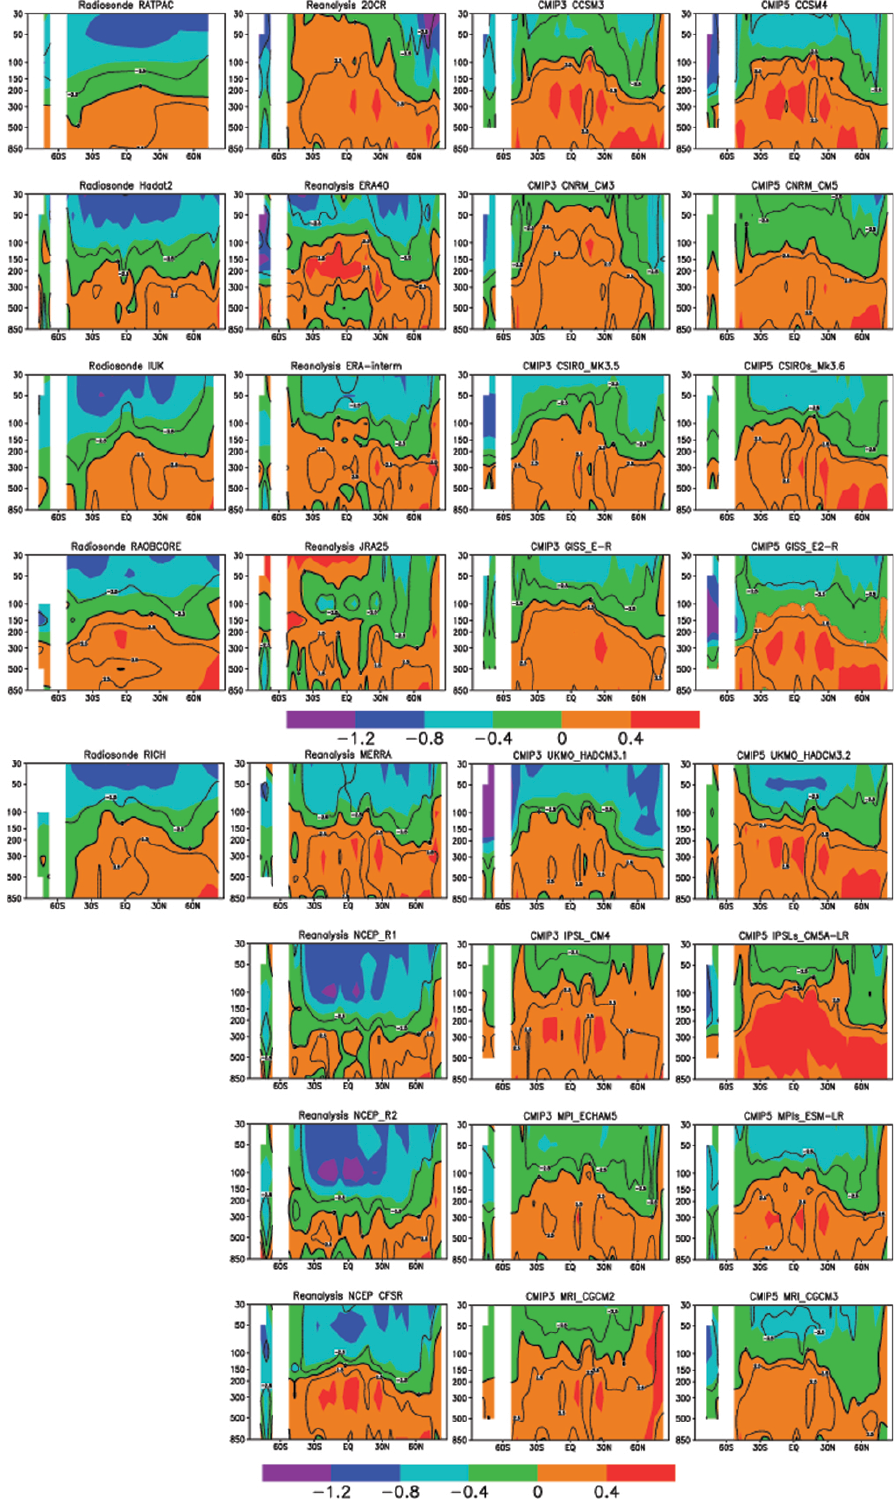
Fig. 1. Vertical–latitudinal distribution of zonal mean temperature trends ( ◦ Cdecade − 1 ) from 1979 to 2005. Radiosondes: left panel; reanal- yses: left middle panel; CMIP3 models: right middle panel; CMIP5 models: right panel. The dashed line with the value of ± 2.5 indicates the statistical significance t test at 99%